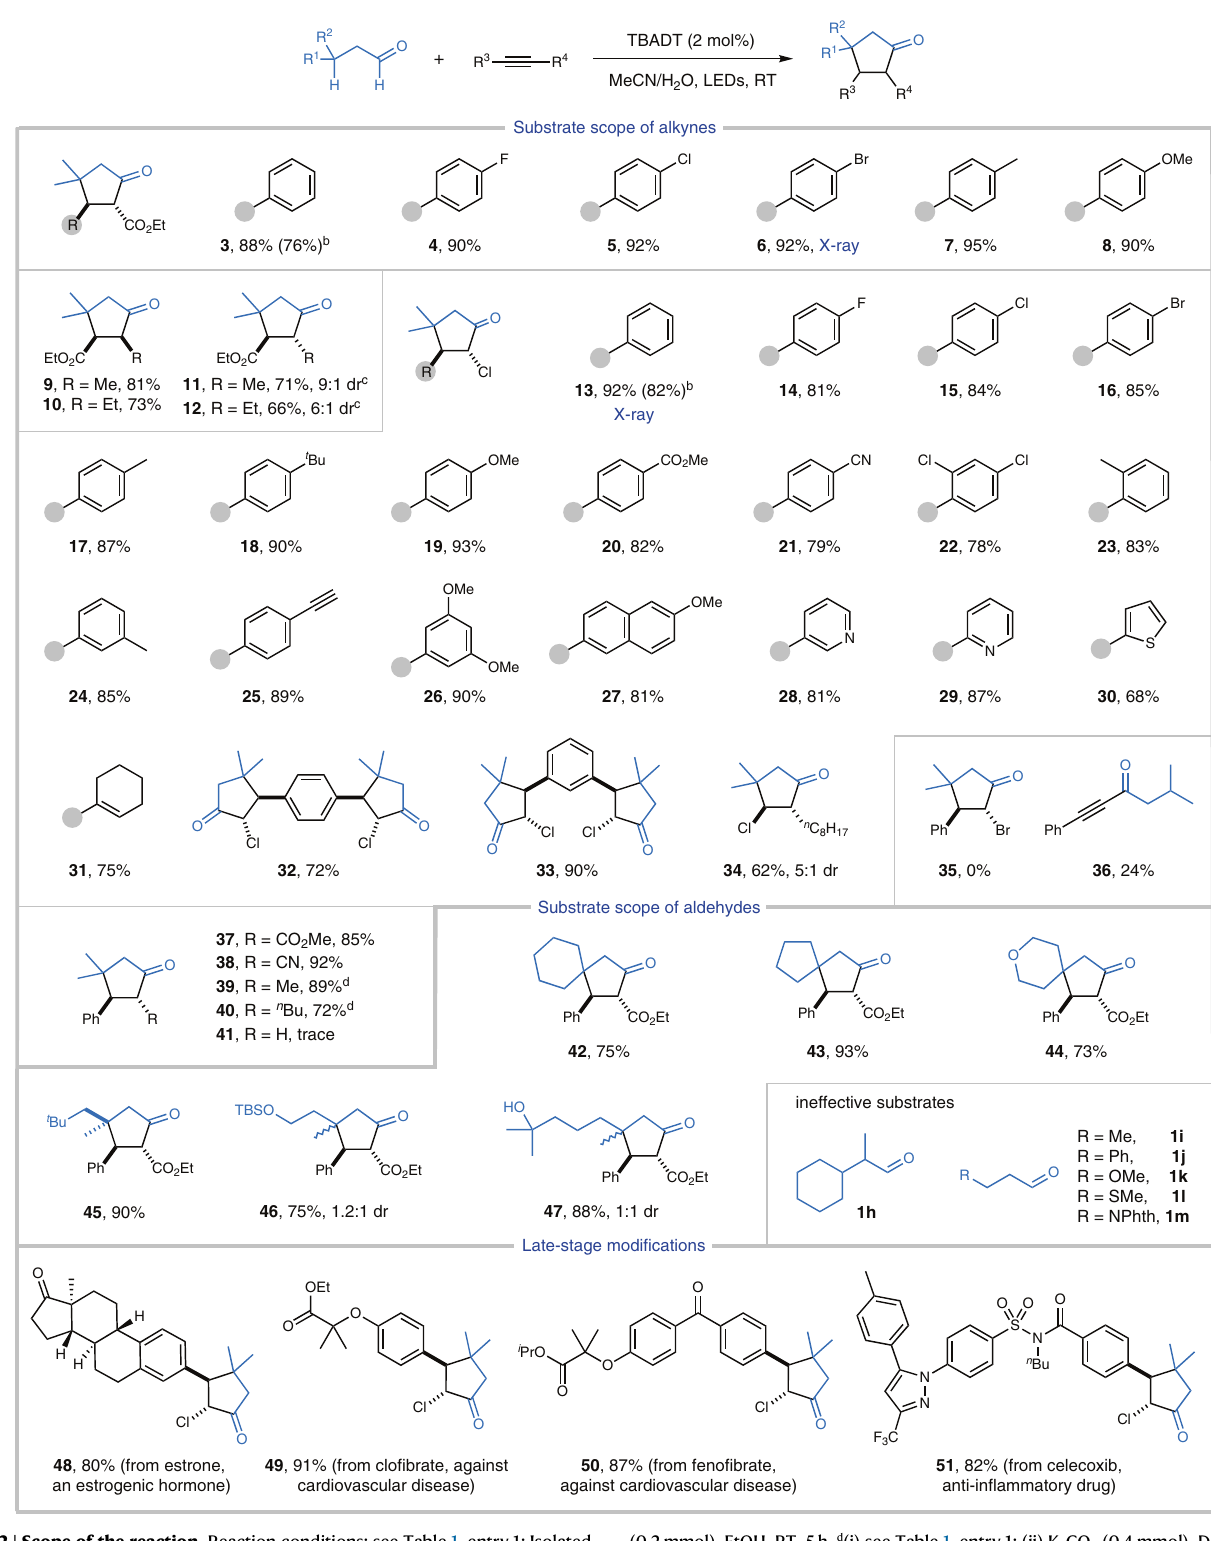
(0.2mmol), EtOH, RT, 5h. d (i) see Table 1, entry 1; (ii) K 2 CO 3 (0.4mmol), DMSO, 80°C, 5h. Dr diastereoisomer ratio. TBS tert -butyldimethylsilyl. RT room